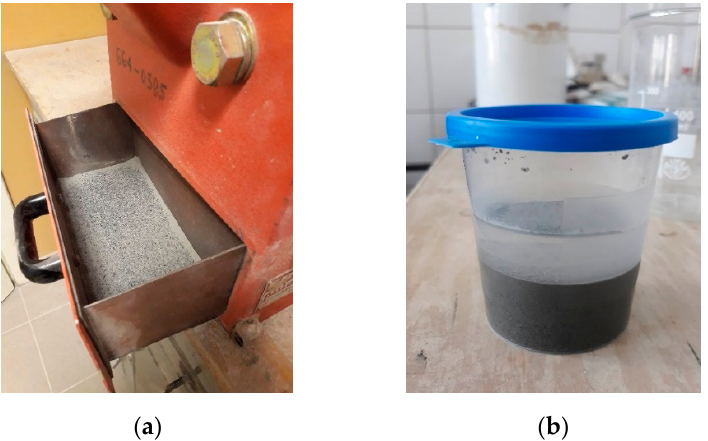
Figure 3. Concrete pH testing procedure: ( a ) specimen after grinding; ( b ) finely crushed concrete: distilled water 1:1 solution.